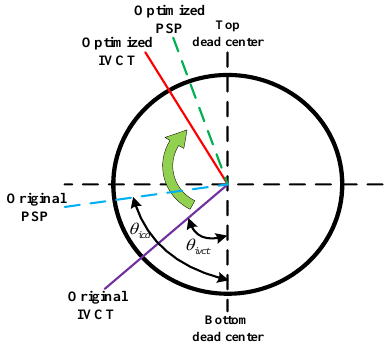
Figure 9. Intake valve close timing optimization before engine ignition.